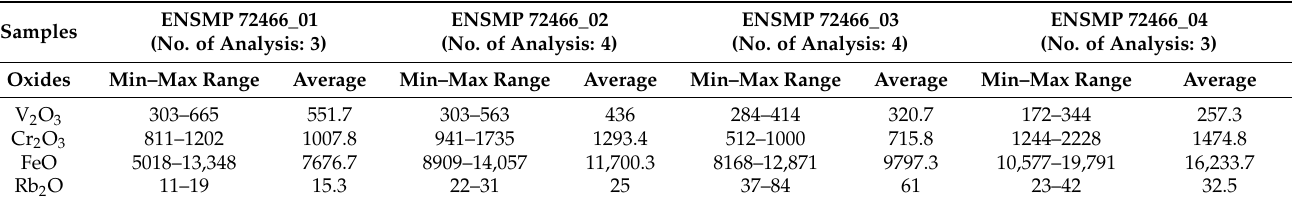
Table 3. Results of EDXRF analysis of single-crystal Egyptian emerald samples in ppm.